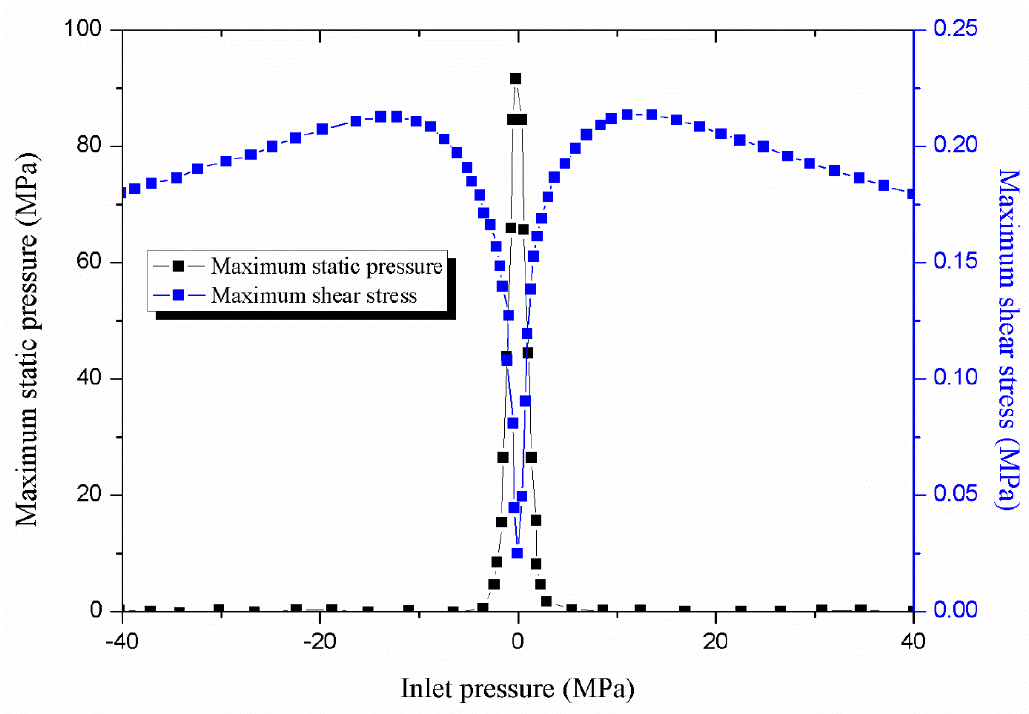
Figure 12. Predicted static pressure and shear stress distribution along the target surface under inlet pressure of 100 MPa.